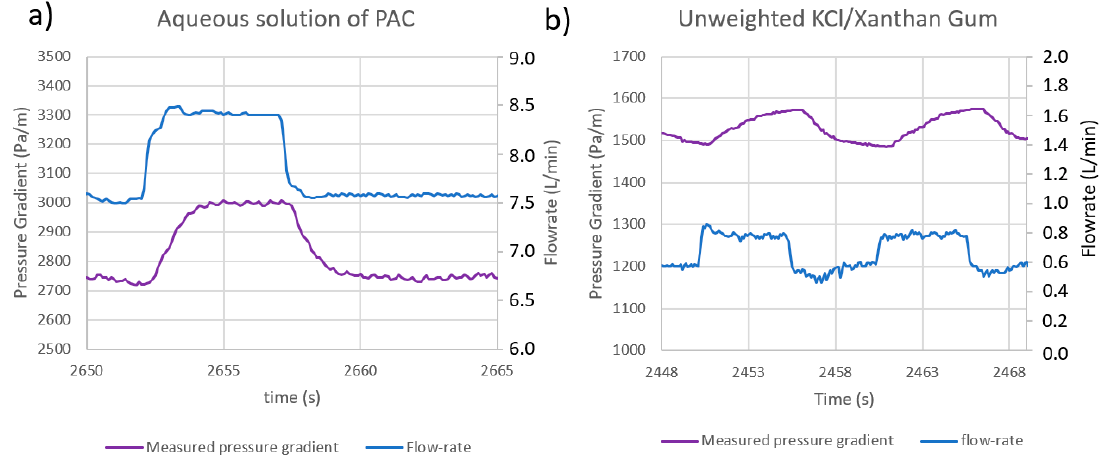
Figure 22. ( a ) The application of volumetric flowrate step changes on a non-thixotropic fluid (here an aqueous solution of PAC) results in a pressure gradient evolution that is only influenced by momentum effects, ( b ) a thixotropic fluid (here a KCl xanthan gum aqueous solution) responds differently to similar volumetric flowrates as a consequence of the time necessary for the structure parameter to reach equilibrium.